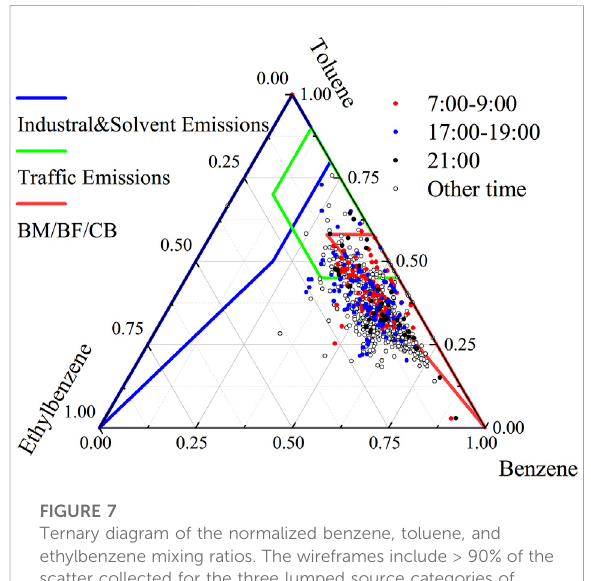
Ternary diagram of the normalized benzene, toluene, and ethylbenzene mixing ratios. The wireframes include > 90% of the scatter collected for the three lumped source categories of industrial and solvent emissions, traf fi c emissions, biomass/ biofuel/coal burning